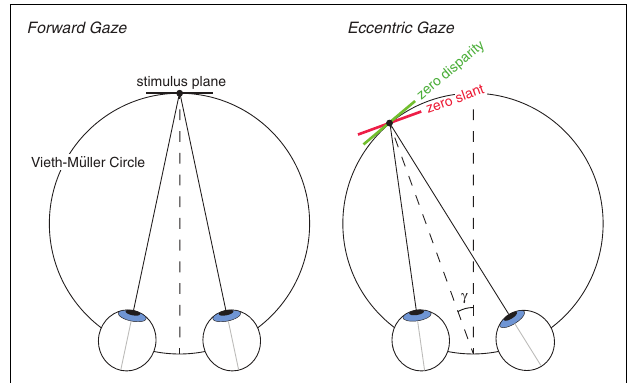
FIGURE 3 | Zero disparity and zero slant for different directions of gaze. Left: The eyes are in forward gaze. The zero-disparity and zero-slant surfaces are both tangent to the Vieth-Müller Circle and are therefore identical. Right: The eyes are in leftward gaze. The zero-disparity surface is again tangent to the Vieth-Müller Circle, but the zero-slant surface is not. The slants of the two surfaces differ by γ , the horizontal version of the eyes. Thus, with viewing in eccentric gaze, the predictions for zero-disparity and zero-slant preferences